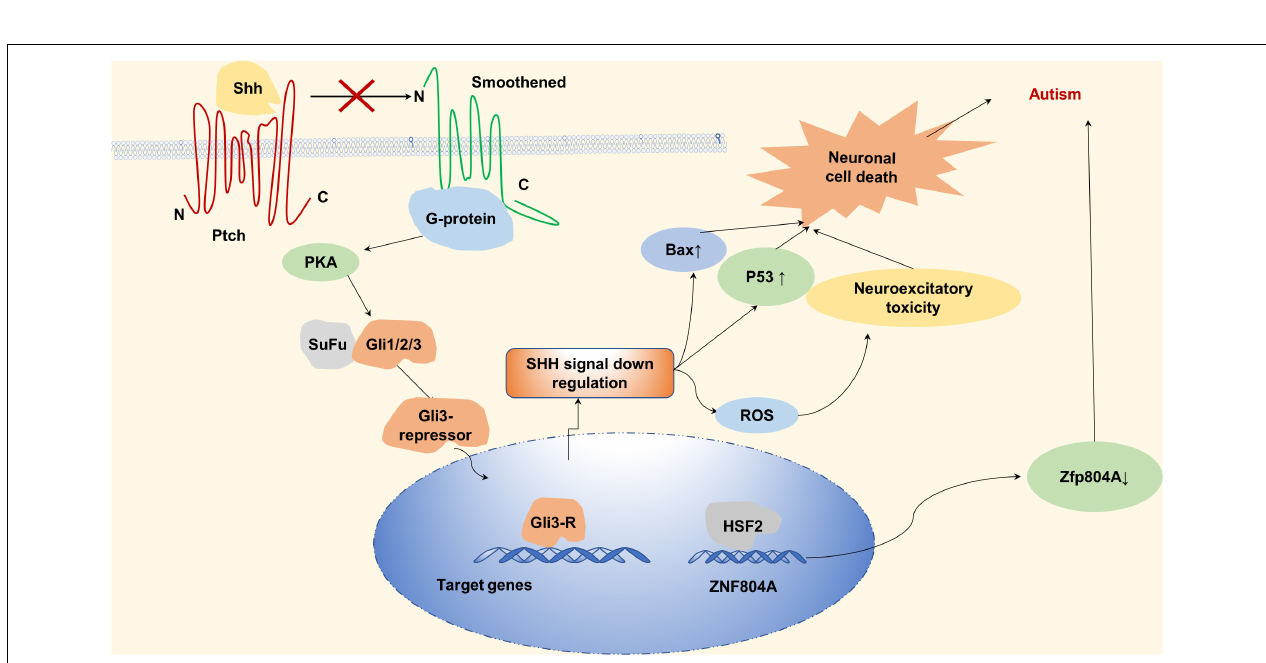
FIGURE 6 | Zinc finger proteins (ZNF) associated with autism. Sonic hedgehog can bind to the receptor Patched (Ptch), Ptch binds and activates Smoothened (SMO) to form complexes that activate Gli and promote downstream gene expression by entering the nucleus as a transcription factor. In the absence of sonic hedgehog, sonic hedgehog (SHH) ligand does not bind to the receptor of Patch1 under stress conditions, PTCH inhibits SMO, and Gli proteins are phosphorylated by protein kinase A (PKA) to form A gli3-repressor that repress transcription of target genes. Downregulation of SMO-SHH signal, abnormal increase of oxidative stress and neuronal inflammation lead to the occurrence of autism. Autism is associated with reduced expression of the ZNF804A.